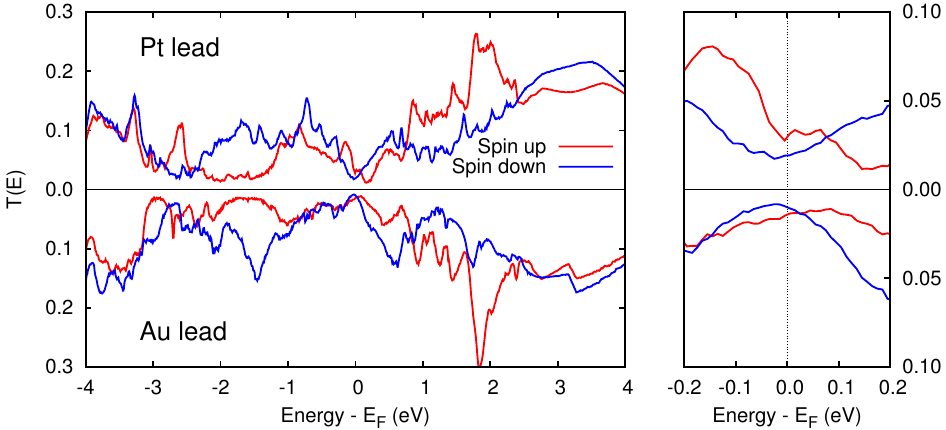
Figure 6. Left panel: spin resolved transmission function of the Pt/Cr/MgO/Pt and Au/Cr/MgO/Au devices, calculated with the Büttiker–Landauer formalism. Right panel: magnification of the region near E F is reported. The energy is referred to the Fermi